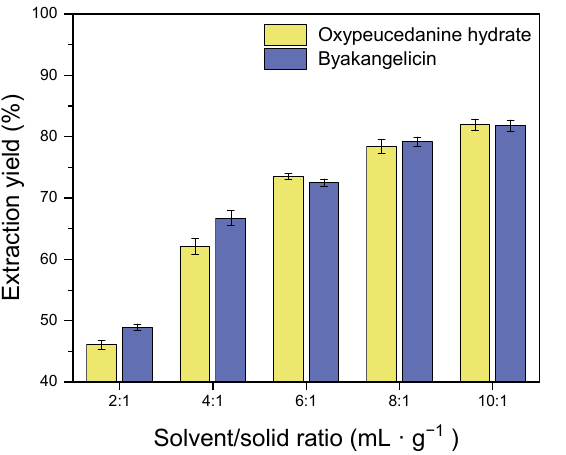
Figure 3. Effect of solvent/solid ratio on the extraction of oxypeucedanin hydrate and byakangelicin.